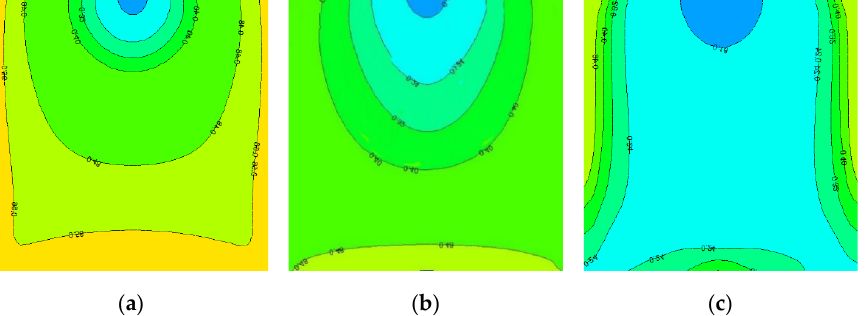
Figure 15. Remaining oil distribution of each layer after water flooding stage of Figure 4: ( a ) low-